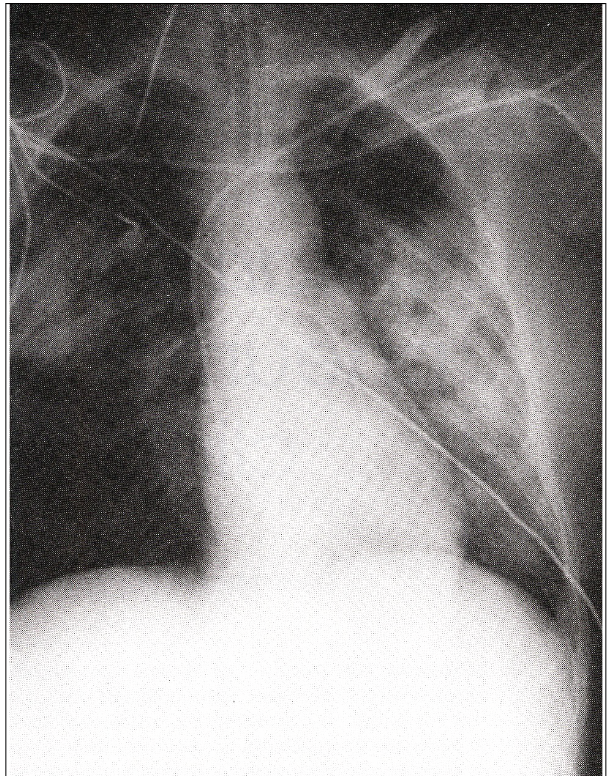
Fig ure 2) Chest ra dio graph of case 1. This ra dio graph was taken about 4 h af ter the one shown in Fig ure 1. Note there is more ex ten sive in volve ment of the right